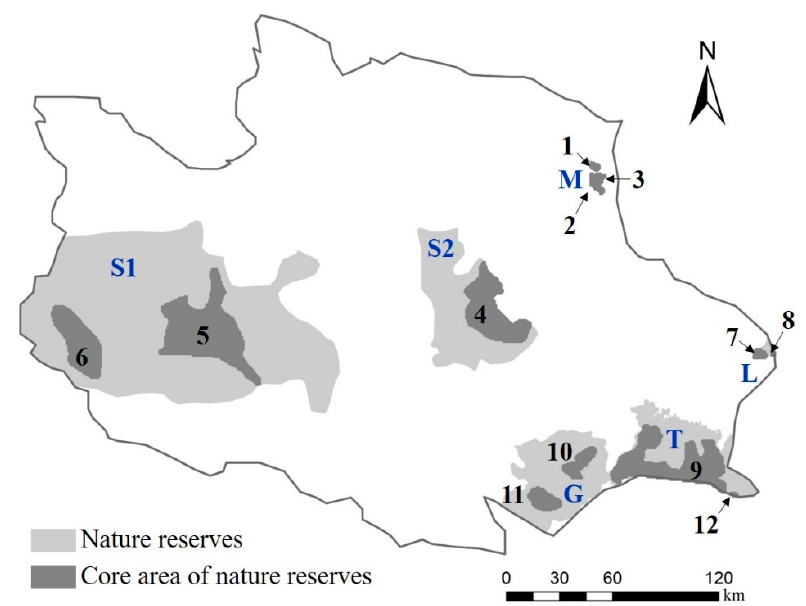
Figure 3. Distribution and number of ecological source regions. 1–12 represents the core areas of the Mengda National Nature Reserve (M), Sanjiangyuan National Nature Reserve (S2, S1), Lianhuashan National Nature Reserve (L), Taohe National Nature Reserve (T) and Gahai-Zecha National Nature Reserve (G), respectively. The source regions were used in the analysis of spatial dynamics in landscape connectivity.